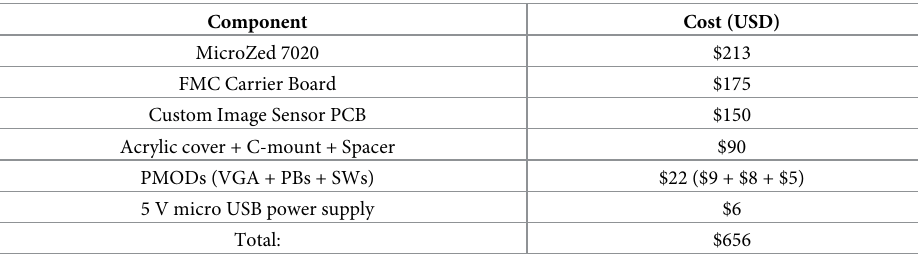
Table 3. Cost breakdown of the